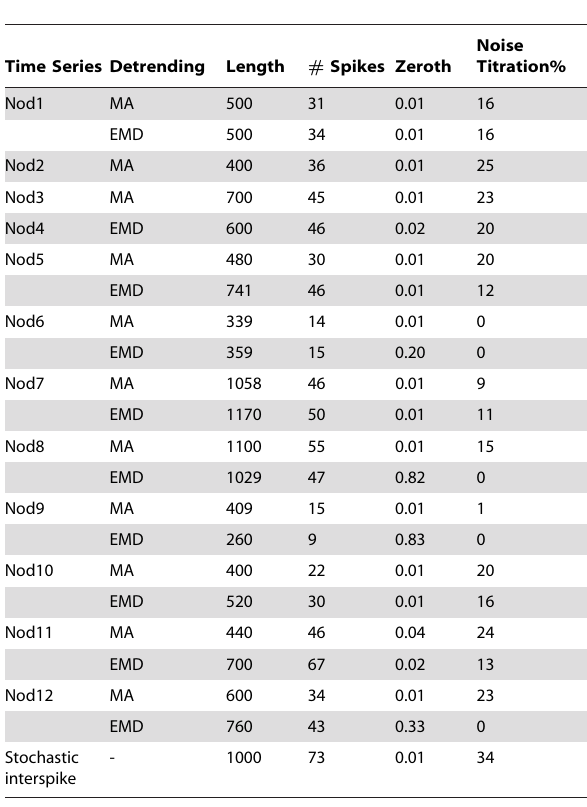
Table 1. Stationary time series of Ca concentration with lengths given by the number of